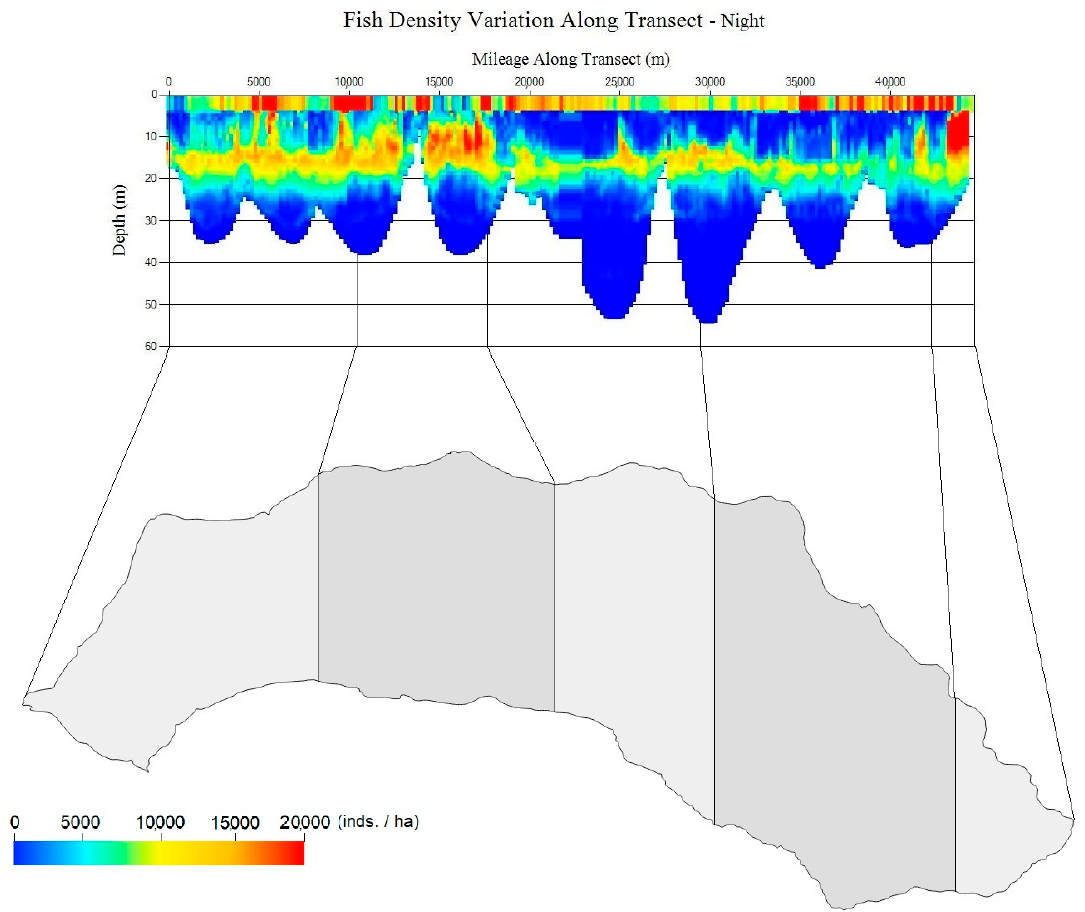
Figure 8. Color map of nighttime fish density depth-wise and along transect variations. Figure is spatially referenced with respect to the lake. Water 2020 , 12 , 1823